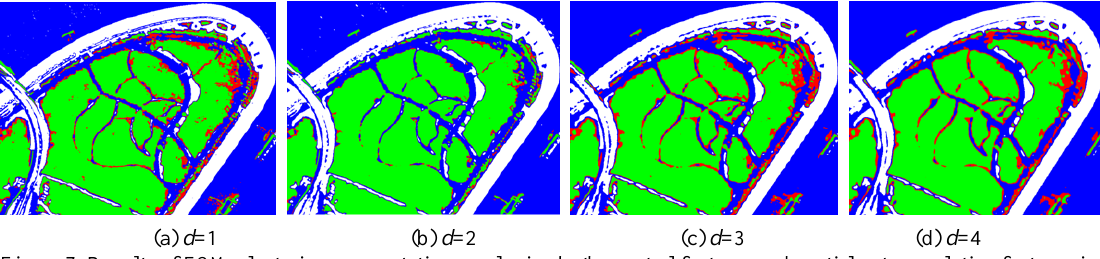
Figure 7. Results of FCM clustering segmentation employing both spectral features and spatial autocorrelation features in site 1 when window width (2 d +1) is less than the maximum range